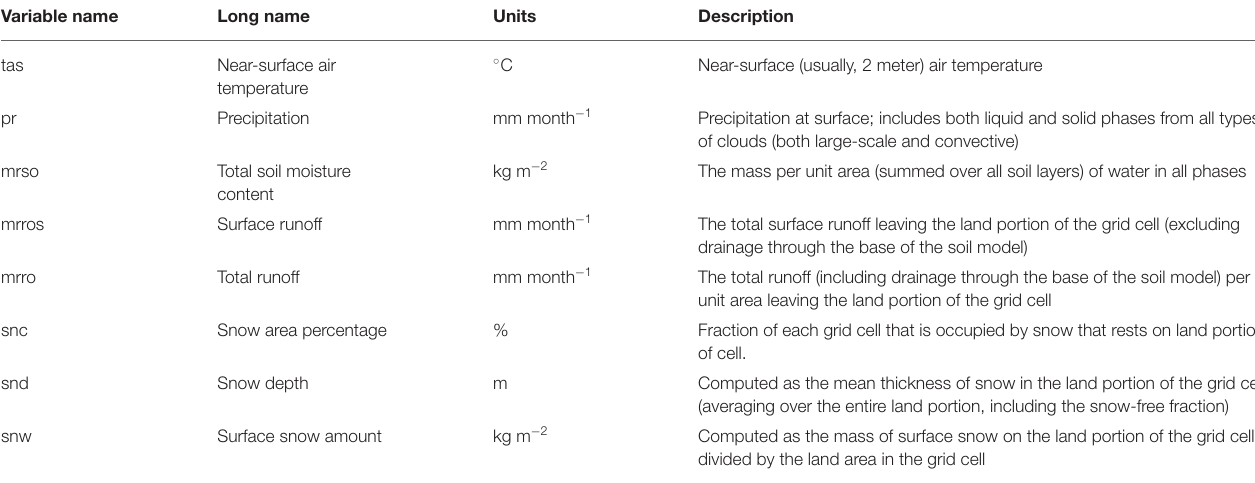
TABLE 1 | Description of the variables of the IPSL-CM6A-LR model analyzed for the evaluation of the changes in the hydrological cycle over the